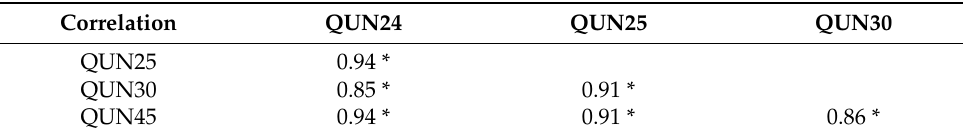
Table 1. Correlation coefficients among tree ring oxygen isotopes.